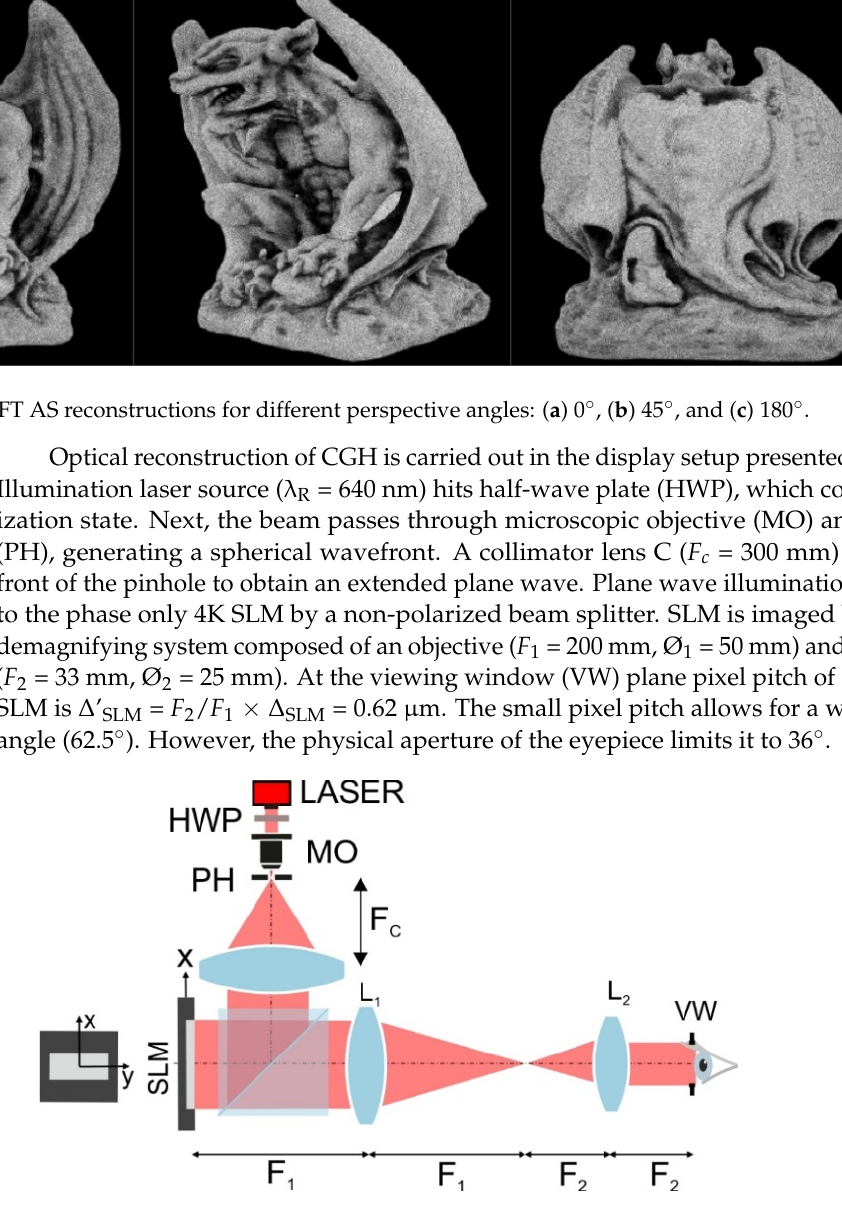
13 of 16 Figure 7a–c show numerical reconstructions for three perspectives angles: 0°, 45°, and 180° of CGH calculated with the 2D MFFT-AS, respectively. Notably, the application of the occlusion culling based PAS algorithm allows eliminating unwanted back points, and